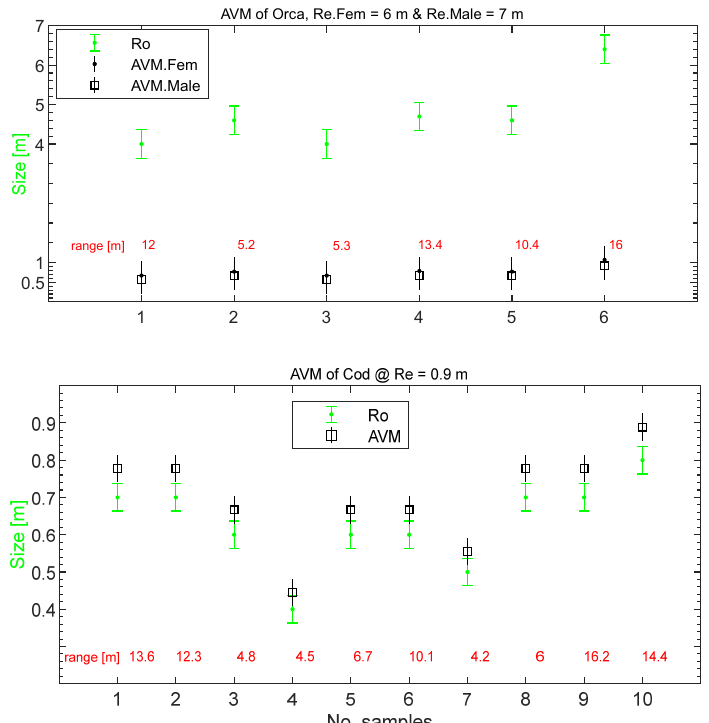
Figure 3. The Acoustic Visibility Measure ( AVM ) of ( a ) harbour, ( b ) grey seals, ( c ) orca and ( d ) cod. Re.Fem and Re.Male are the expected size for female and male animals respectively, and Ro is the observed size. The expected size ( Re ) values were retrieved from the literature [28–30,31]. The range in which these targets were detected is given in red. The standard error is represented by the error bars with caps. The y-axis represent both the nondimensional AVM and the unidimensional size of targets.